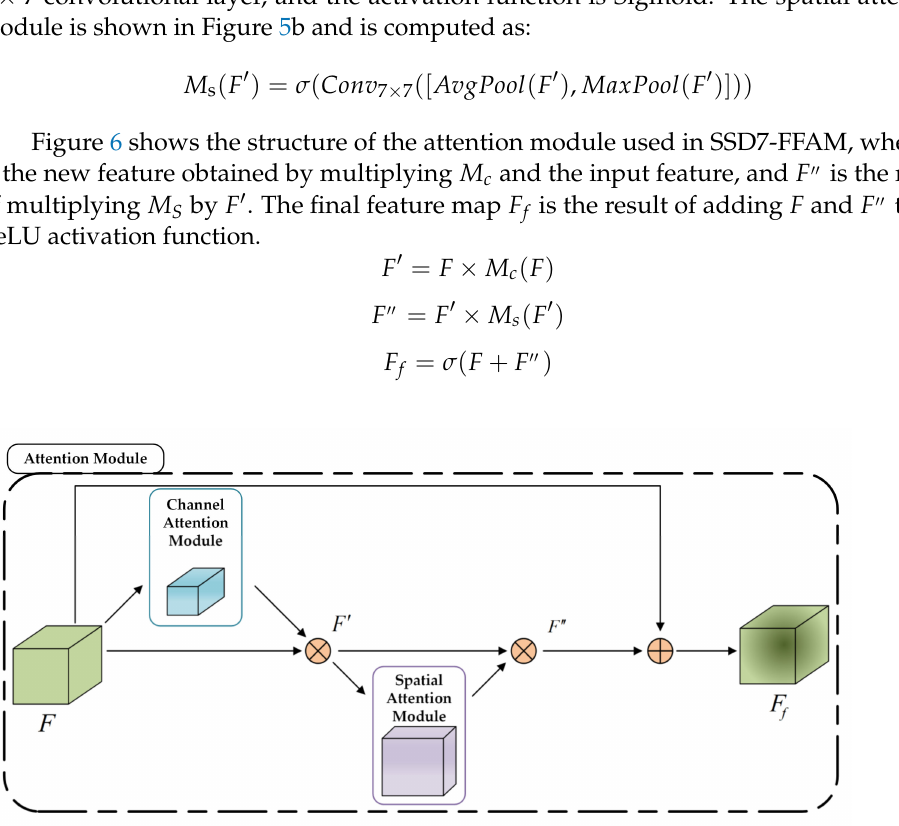
Figure 6. The structure of the attention module used by